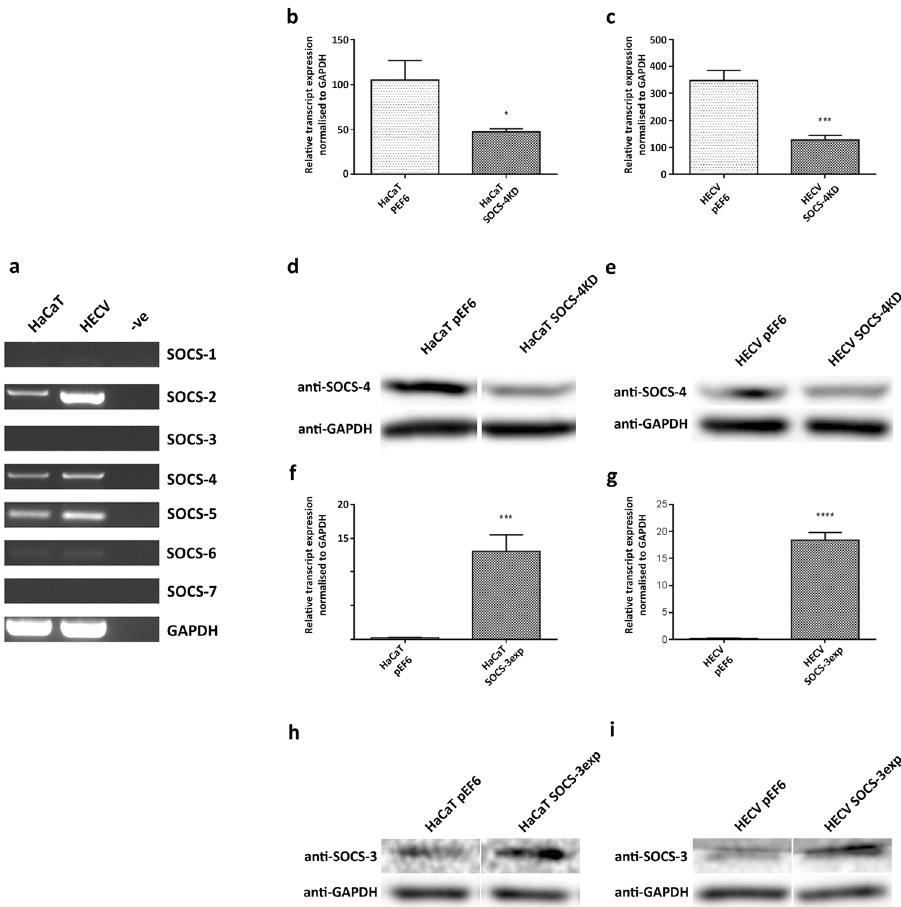
Figure 1. Expression profile and generation of SOCS-3 over-expression and SOCS-4 knockdown models. ( a ) RT-PCR screening of HaCaT and HECV cell lines for SOCS-1 (108 bp), SOCS-2 (461 bp), SOCS-3 (521 bp) SOCS-4 (541 bp), SOCS-5 (117 bp), SOCS-6 (131 bp), SOCS-7 (590 bp) and GAPDH (475 bp), negative control (-ve) represents amplification of molecular biology grade water instead of cDNA. Verification of SOCS-4 transcript knockdown was assessed and confirmed using q-PCR in ( b ) HaCaT and ( c ) HECV cell lines. Protein knockdown in ( d ) HaCaT and ( e ) HECV cells were verified using western blot analysis. Verification of SOCS-3 over-expression at transcript level was confirmed using q-PCR in ( f ) HaCaT and ( g ) HECV cell lines. Protein knockdown was verified in ( h ) HaCaT and ( i ) HECV cells using western blot analysis. RT-PCR and western blot data represents cropped images, full length gels and blots are included in supplementary information. Representative data of a minimum of three independent repeats shown, error bars represent standard deviation, * represents p < 0.05, *** represents p < 0.001, **** represents p <